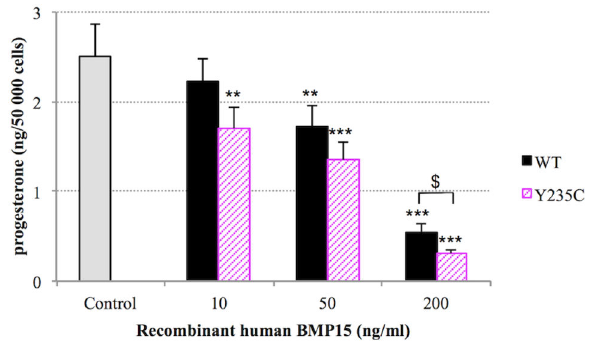
Figure 4. Recombinant BMP15 inhibition of progesterone